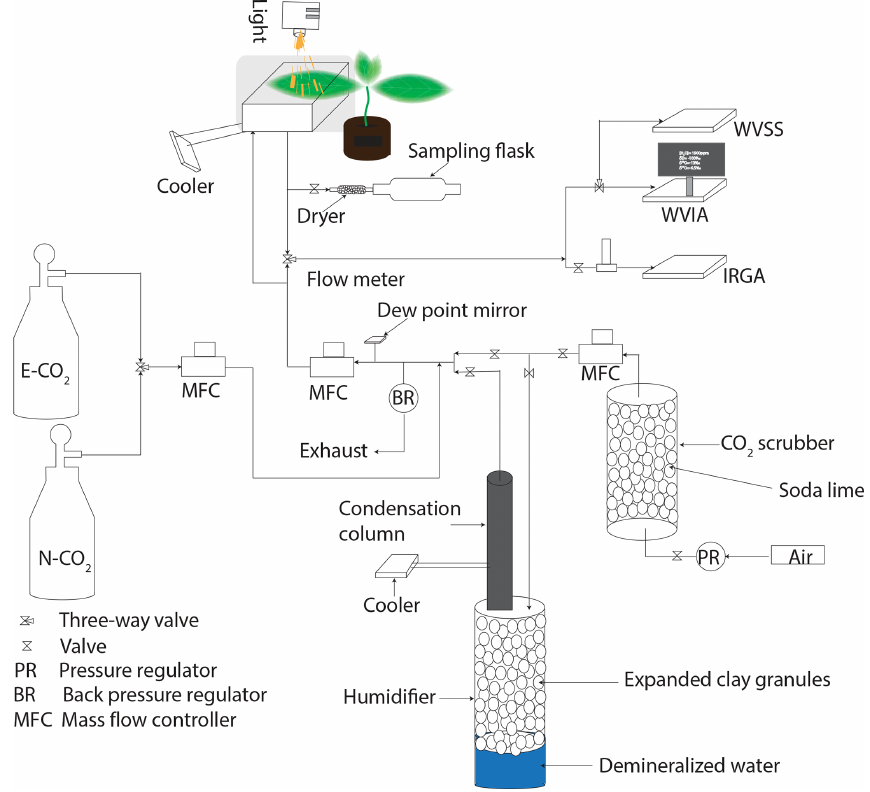
Figure 2. Schematic diagram of the leaf cuvette experimental setup. IRGA stands for the infrared gas analyzer, WVSS is the water vapor standard source, WVIA is the water vapor isotope analyzer, N-CO 2 is normal CO 2 , and E-CO 2 is 17 O-enriched CO 2